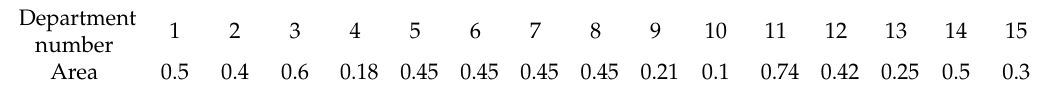
Table A1. The department area of